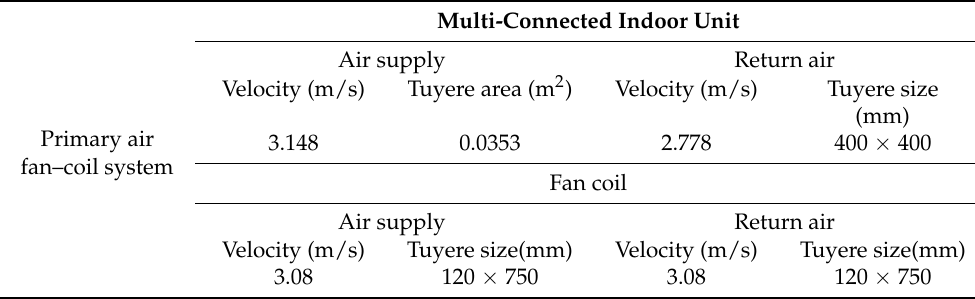
Table 4. Mechanical exhaust and door opening boundary